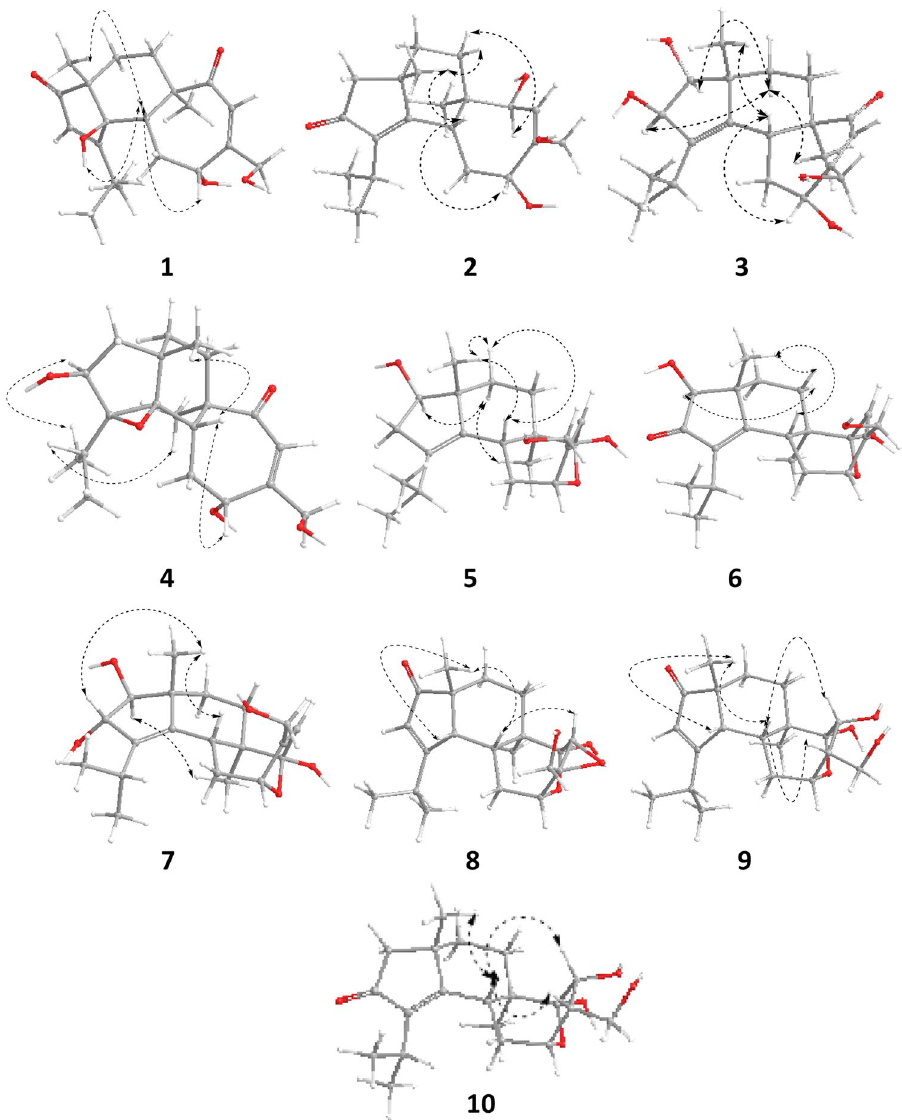
Figure 3. The conformation of 1 – 10 with minimized energy. The arrows show the key NOESY